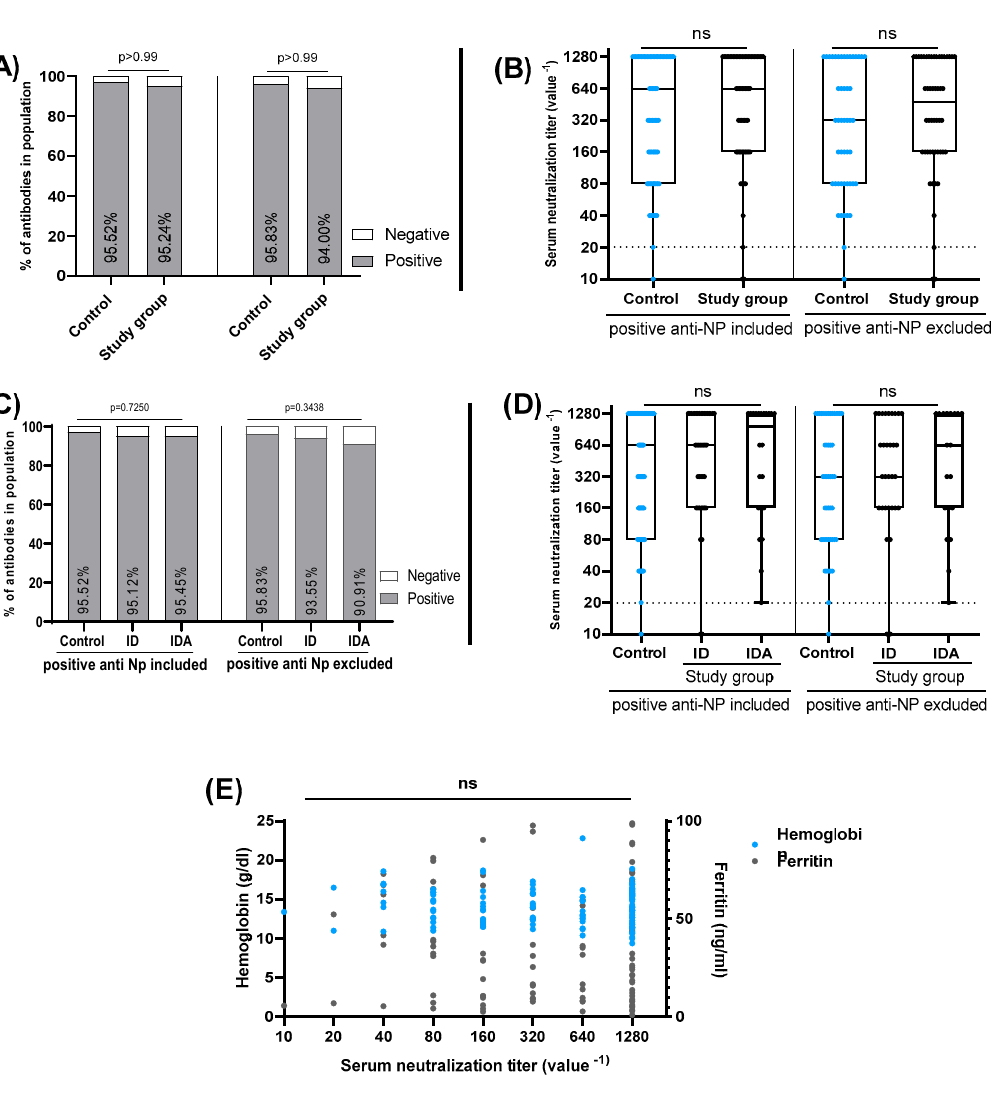
Figure 4. The prevalence of COVID-19 neutralizing antibodies in the control group (normal hemoglobin and ferritin) and study group (ID, IDA). ( A ) The prevalence (%) of neutralizing antibodies in control group and study group (ID and IDA combined) when anti-NP sero-positive cases were included (left) and excluded (right). p values were calculated by Fisher’s exact test. ( B ) Comparison of neutralizing antibody titers among control group and study group (ID and IDA combined) when anti-NP sero-positive cases were included (left) and excluded (right). ( C ) The prevalence (%) of neutralizing antibodies in control group and study group (ID and IDA separated) when anti-NP sero-positive cases were included (left) and excluded (right). p values were calculated by Fisher’s exact test. ( D ) Comparison of neutralizing antibody titers among control group and study group (separated as ID and IDA) when anti-NP sero-positive cases were included (left) and excluded (right). Dashed black line indicates the cut-off value (SN titer ≥ 1:20 were positive). Boxes represents 25th to 75th percentile range, black line demonstrate the median, and whiskers show minimum and maxi- mum values. The horizontal lines represent the medians. p values were calculated by Mann–Whit- ney U test and Kruskal–Wallis test, as appropriate. ns = p value > 0.05. ( E ) Spearman correlation between hemoglobin and ferritin levels and serum neutralization titer. ns = p value < 0.05.